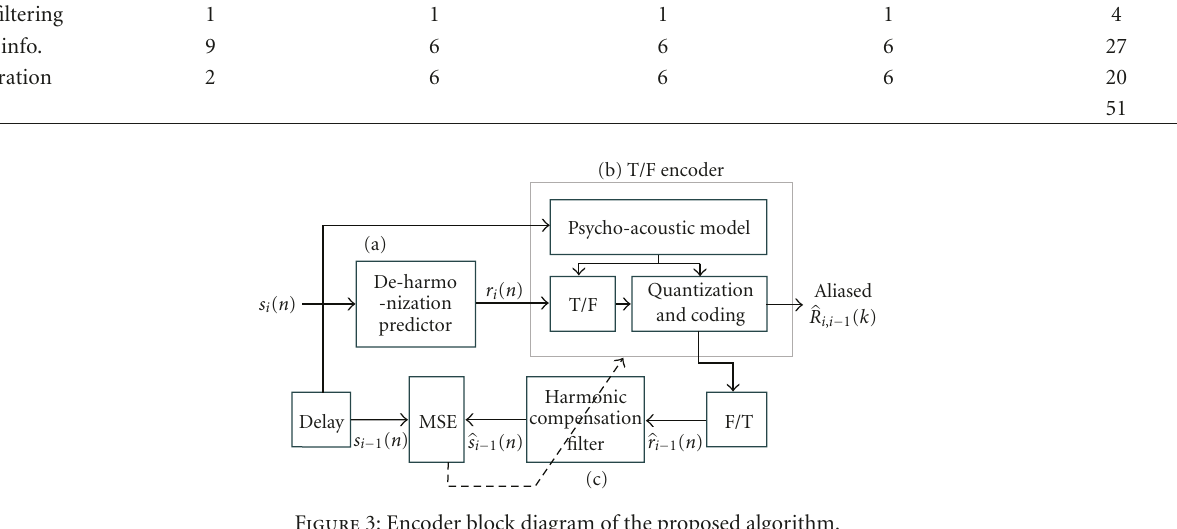
Figure 3: Encoder block diagram of the proposed algorithm.